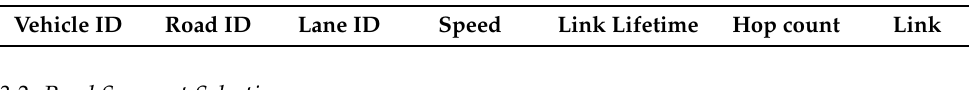
Table 2. The Content of the Beacon Message.